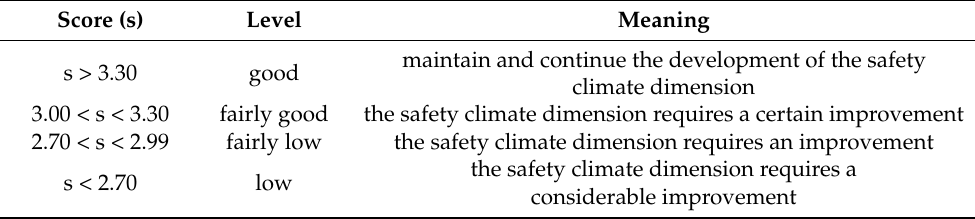
Table 1. Scoring values to evaluate the results of the NOSACQ-50 questionnaire (source: [7]). Score (s) Level Meaning maintain and continue the development of the safety s > 3.30 good climate dimension 3.00 < s < 3.30 fairly good the safety climate dimension requires a certain improvement 2.70 < s < 2.99 fairly low the safety climate dimension requires an improvement the safety climate dimension requires a s < 2.70 low considerable improvement